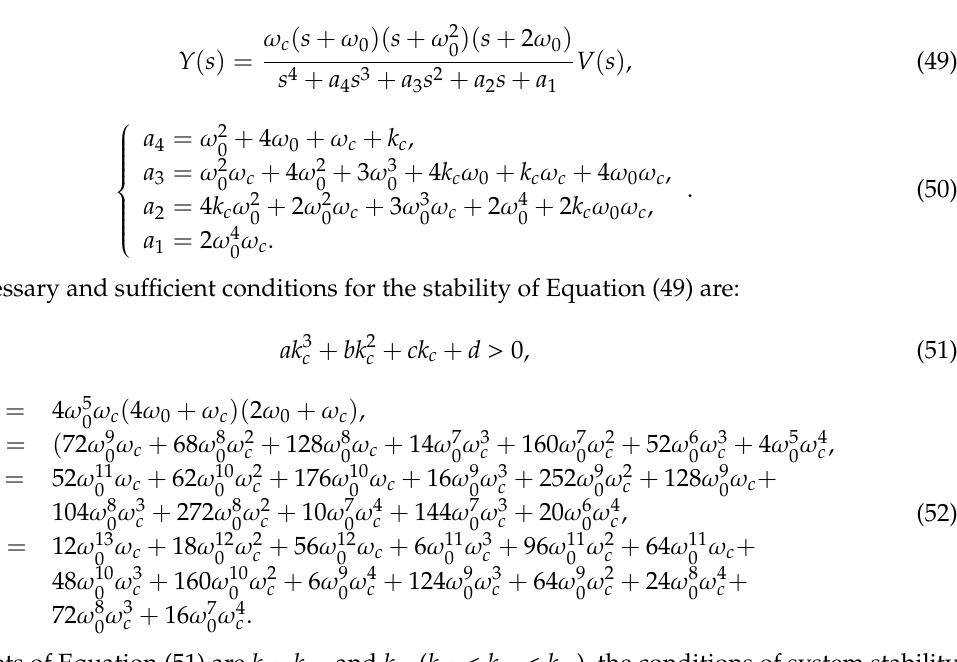
Figure 12. System stability region under di ff erent observer bandwidths ω 0